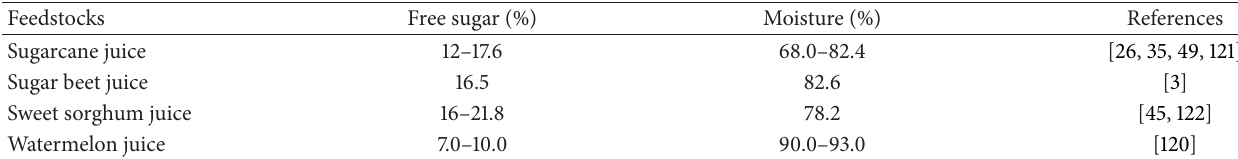
Table 2: Chemical composition of feedstocks derived from different